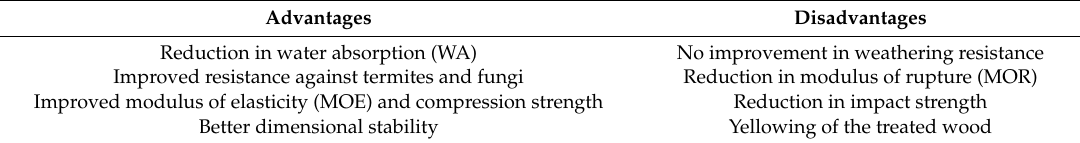
Table 1. Advantages and disadvantages of CA as wood treating